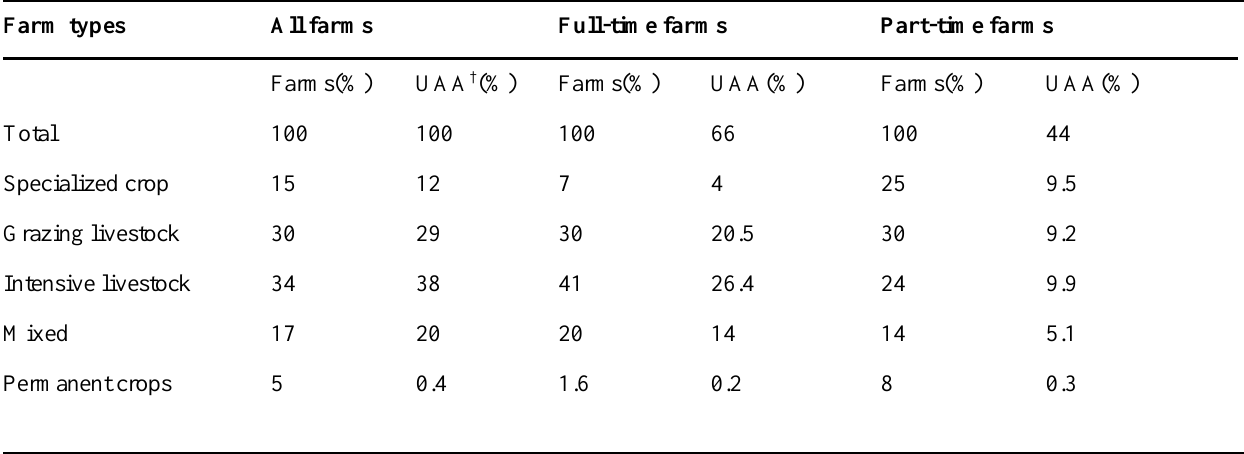
Table 2. Farm structure in Hohenlohe in 1999. † UAA stands for used agricultural area in hectares. Farm types All farms Full-time farms Part-time farms Farms(%) UAA † (%) Farms(%) UAA(%) Farms(%) UAA(%) Total 100 100 100 66 100 44 Specialized crop 15 12 7 4 25 9.5 Grazing livestock 30 29 30 20.5 30 9.2 Intensive livestock 34 38 41 26.4 24 9.9 Mixed 17 20 20 14 14 5.1 Permanent crops 5 0.4 1.6 0.2 8